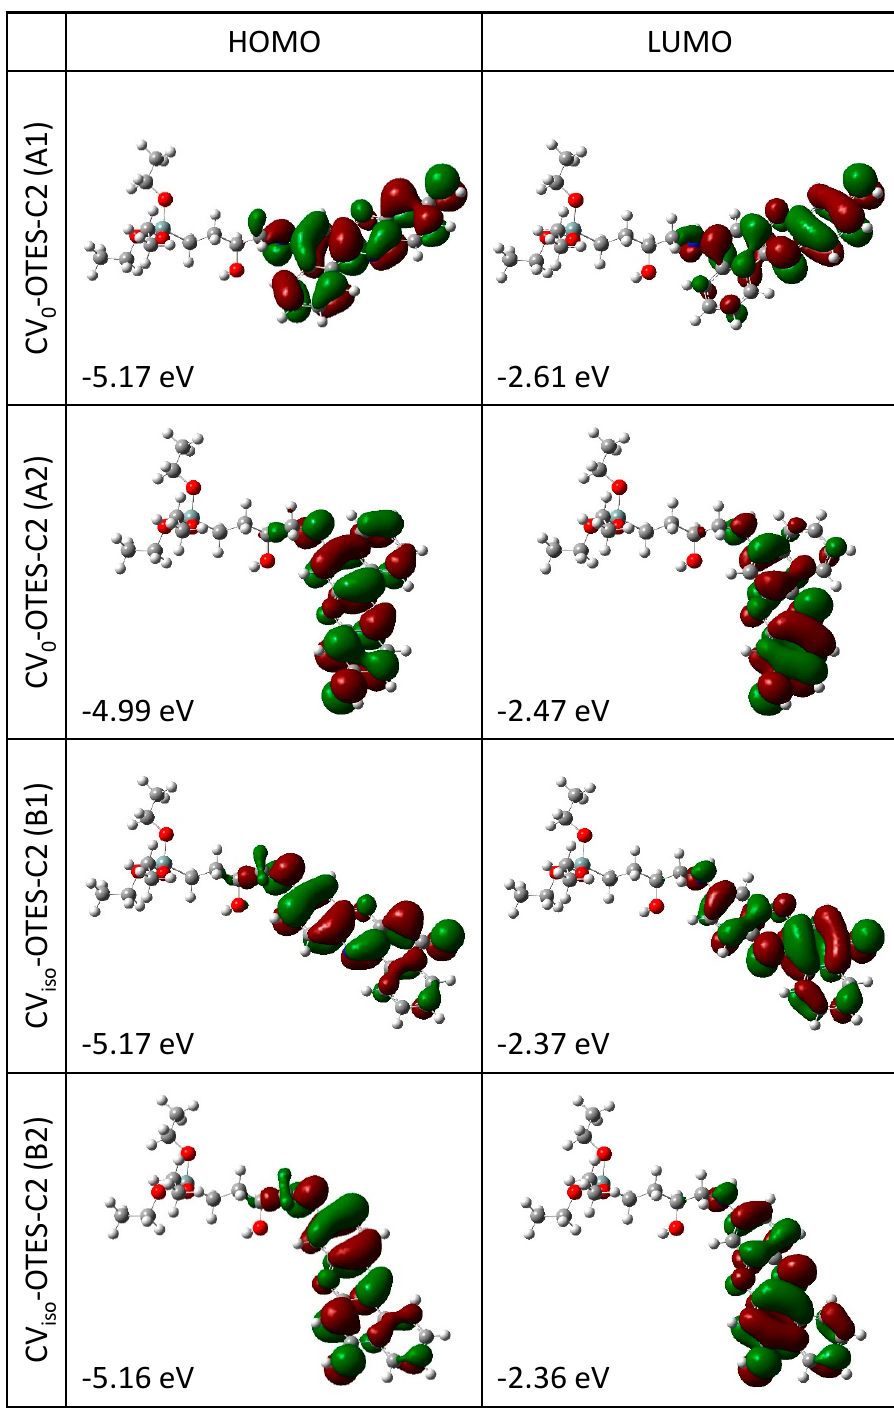
Figure 5. Highest occupied molecular orbitals (HOMO) and lowest unoccupied molecular orbitals (LUMOs) of CV 0 –OTES–C2 and CV iso –OTES–C2 using CPCM in EtOH. Calculations were carried out at the B3LYP/6-31G* level of theory. Surface isovalue: 0.02 e/bohr 3 .